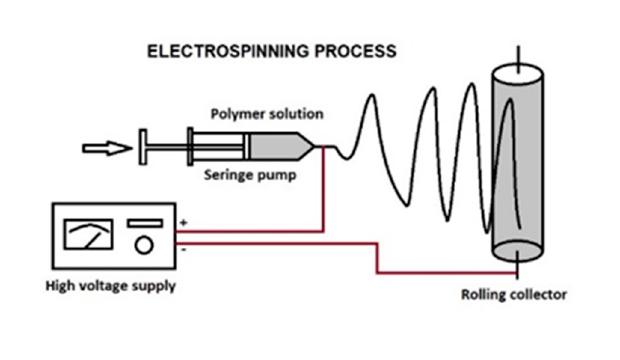
Figure 1. Electrospinning process